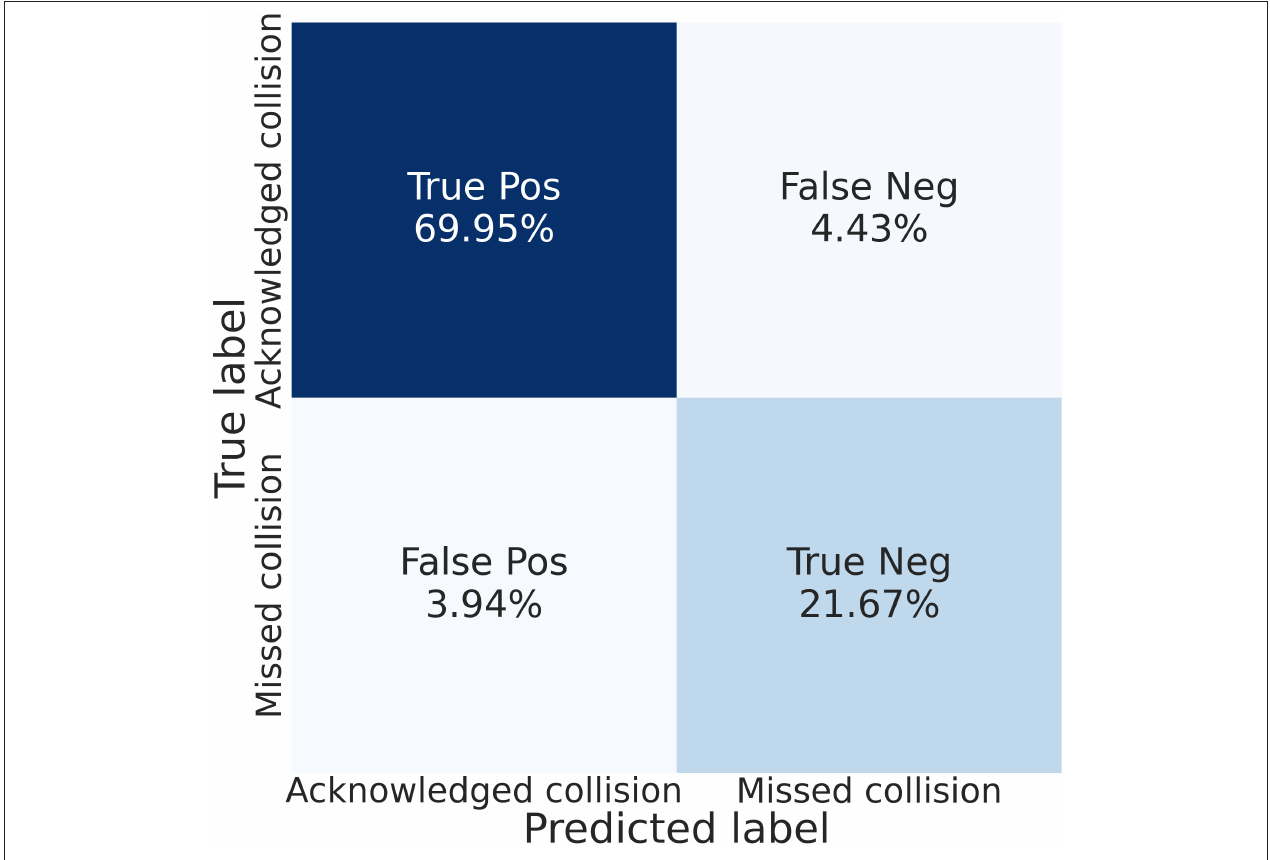
FIGURE 6 | Confusion matrix for the pBCI. The ground truth was obtained using post-hoc manual analysis of the recordings from the eye tracker. Acknowledged collision corresponds to a collision actually spotted on time by the pilot.